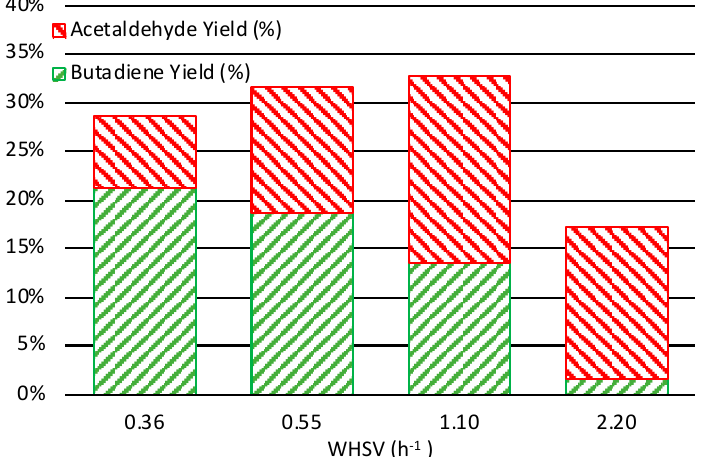
Figure 5. Butadiene and acetaldehyde yields as a function of the contact time for 4TaSi NHSG -5Ag at 355 °C.